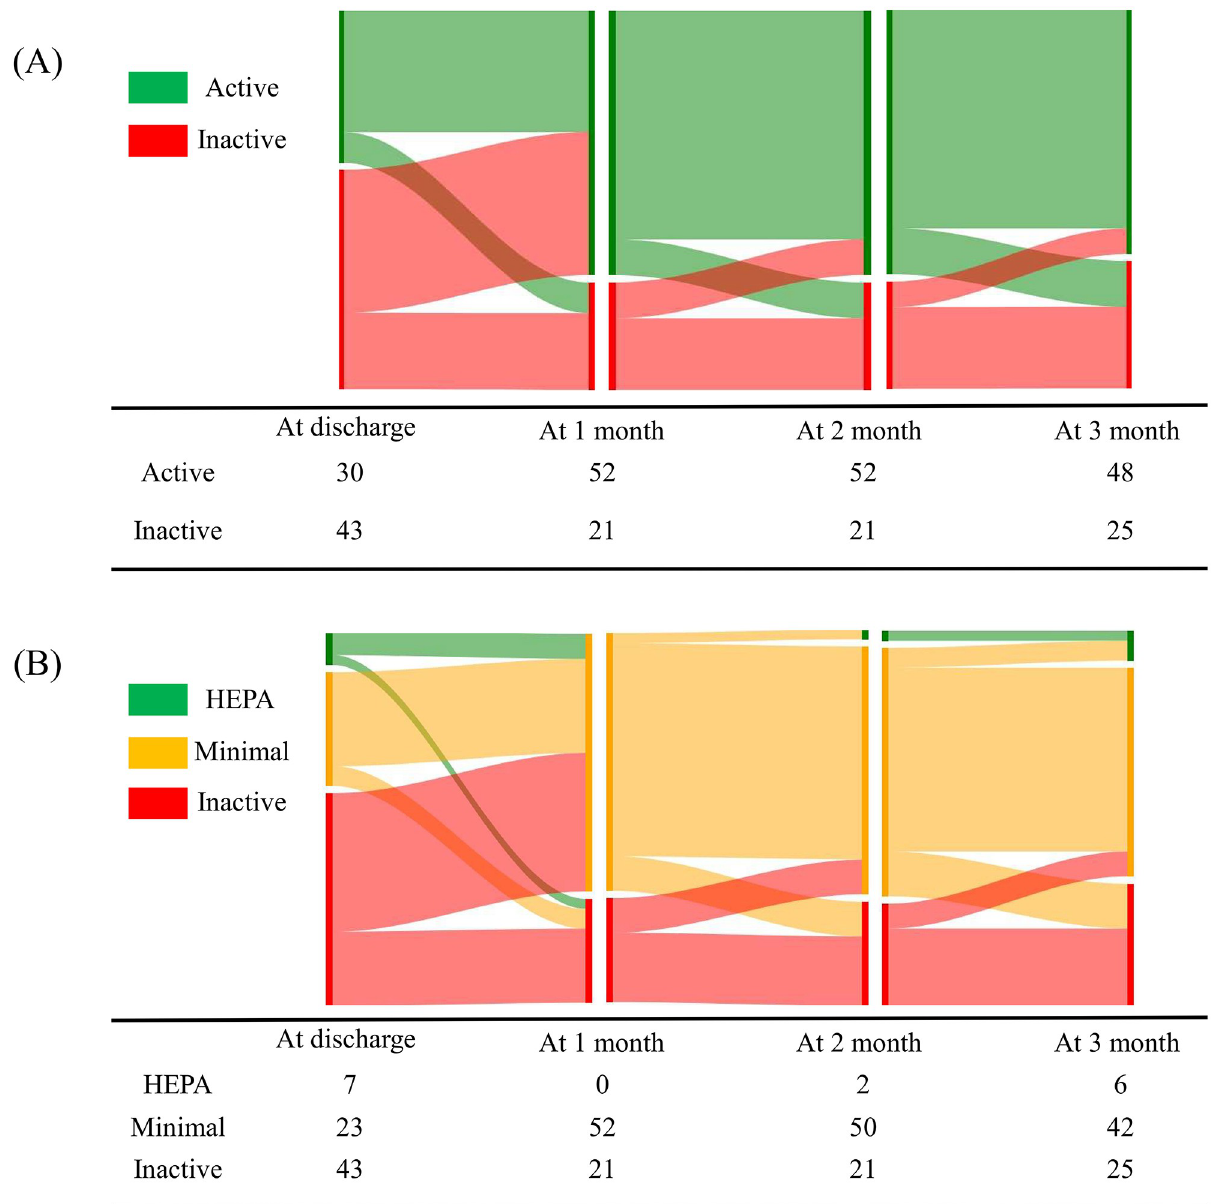
Fig 3. Changes in physical activity ((A): Active and Inactive, (B): Health-enhancing physical activity (HEPA), Minimally active, and Inactive) in the intervention group from discharge to follow-up at 3 months.